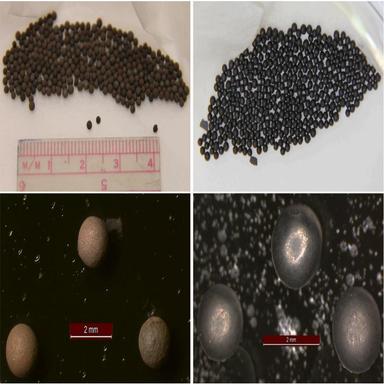
Uncoated (left) and coated by SiC (right) fuel microspheres based on UO2